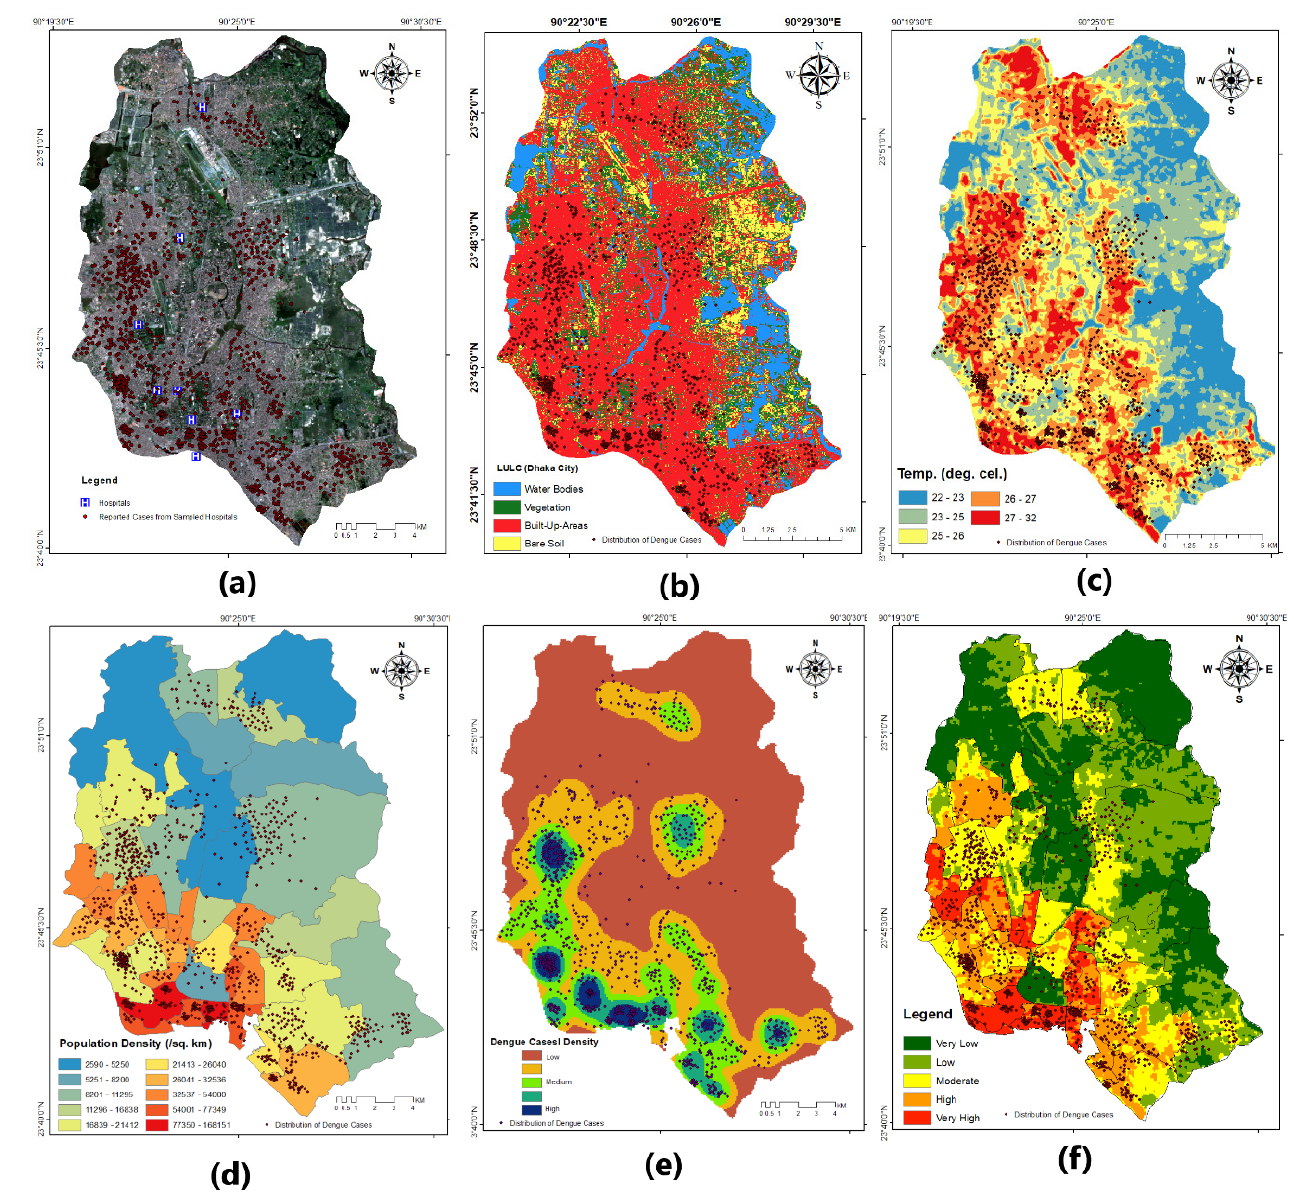
Figure 3. ( a ) Dengue cases location on a true color image of Landsat 8 OLI; red dots show the reported dengue patients in hospitals, ( b ) distribution of Dengue incidence by LULC, and ( c ) influence of UHI in dengue distribution by the ranges of LST; higher-temperature region shows the higher density of reported dengue patients, ( d ) population density in Dhaka City with the number of reported dengue patients distribution, ( e ) dengue incidence density prepared by the interpolation methods, and ( f ) dengue risk map of Dhaka City prepared using the various environmental components; red dots indicate the distribution of reported dengue patients in hospitals.